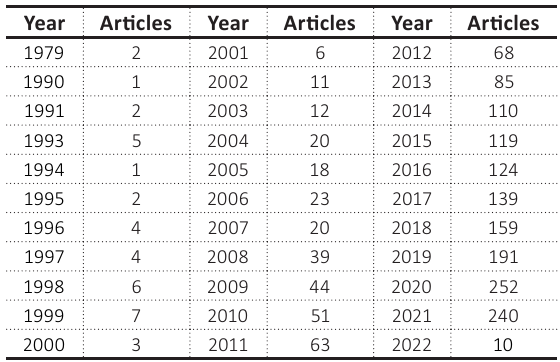
Table 3. Annual scientific production